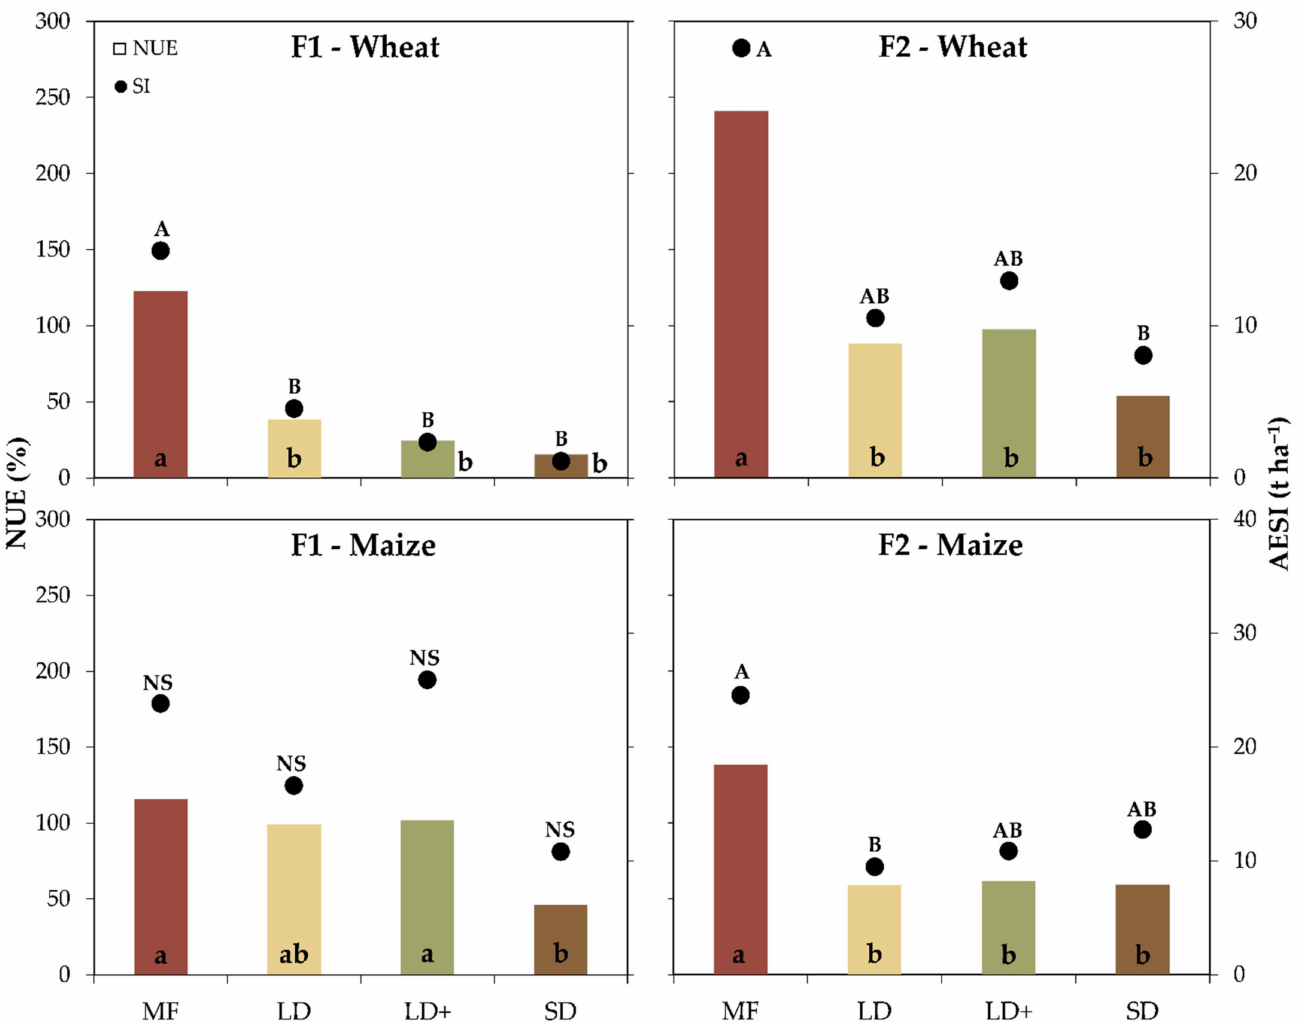
Figure 4. The nitrogen use efficiency (NUE) (bars) and agro-environmental sustainability index (AESI) (points) by treatment for both farms (F1 and F2) and crops (winter wheat and maize). Different letters identified significant differences among treatments according to the Tukey test at p ≤ 0.05. ns = not